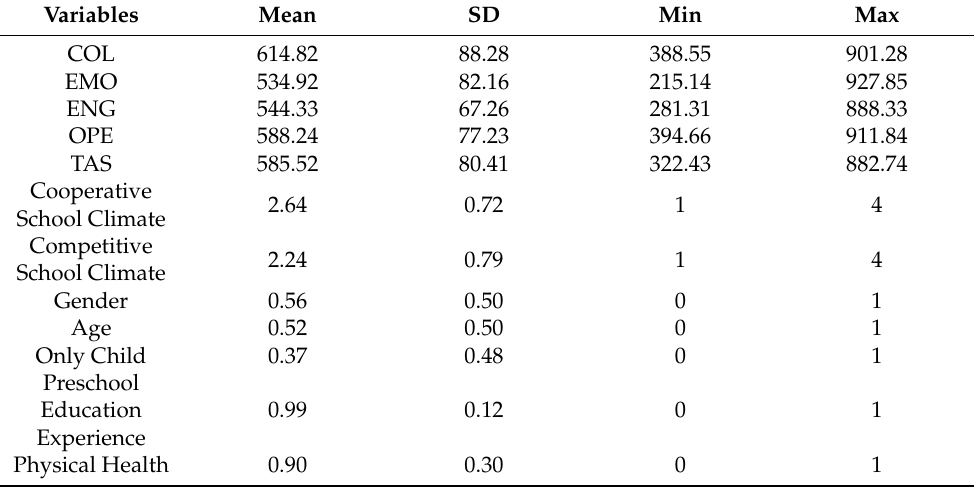
Table 1. Descriptive